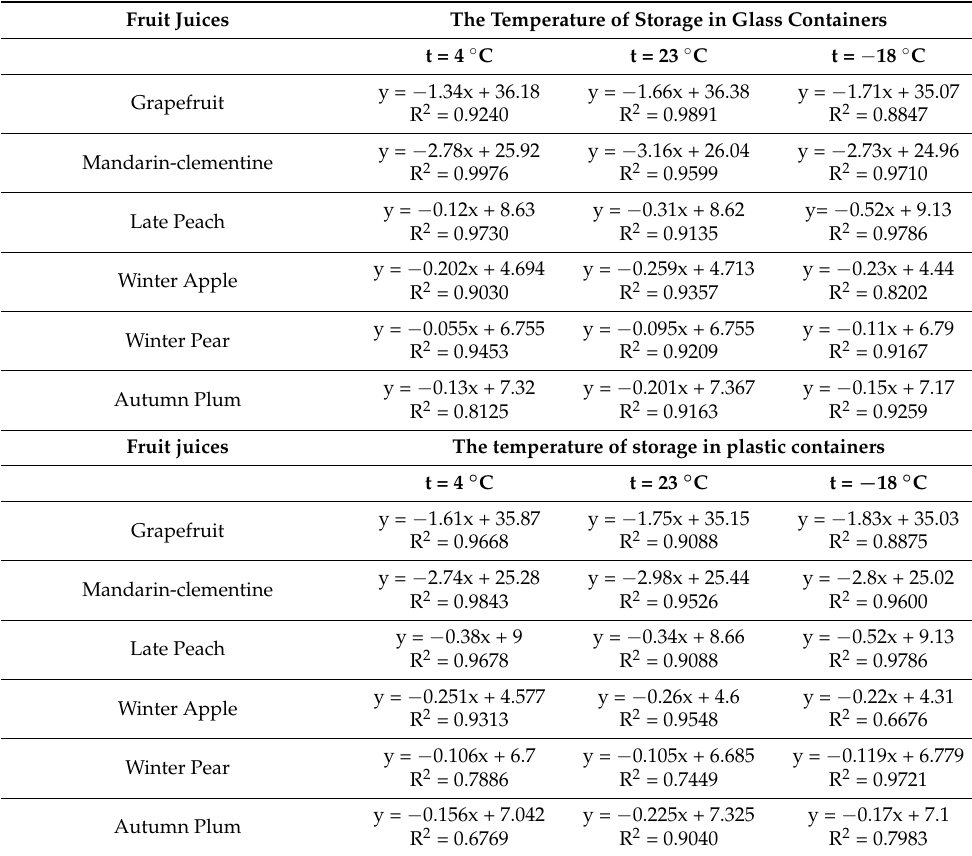
Table 3. A decrease in vitamin C content in fruit juices at different storage temperatures (7